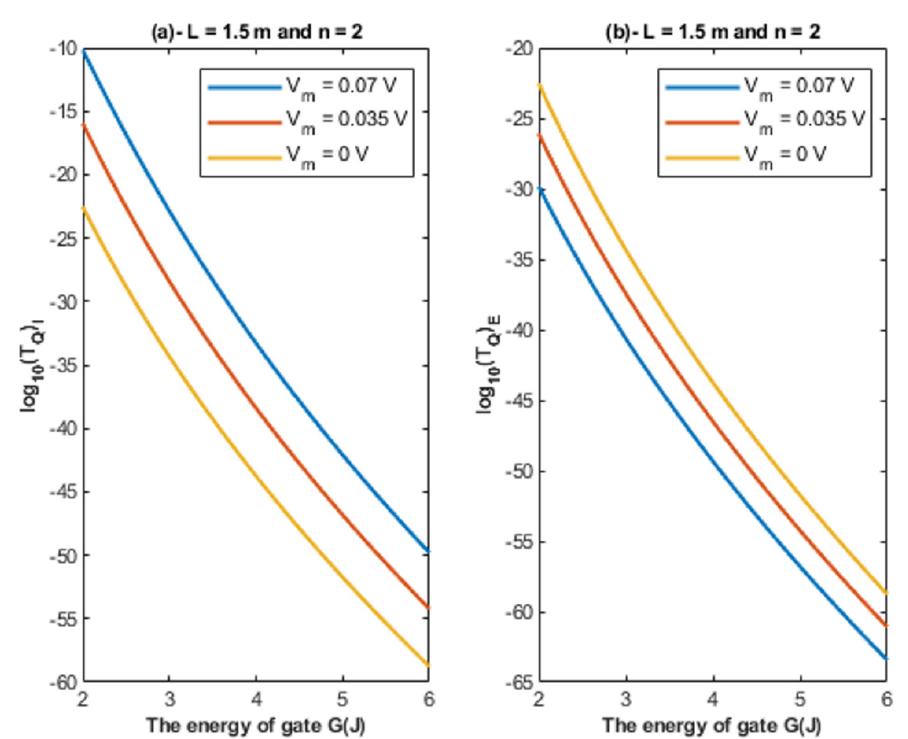
Figure 5. ( a , b ): The figure represents the relationship between the energy of gate G and the common logarithm of the tunneling probability of the intracellular chloride ions log tunneling probability of the extracellular chloride ion s are investigated at different values of membrane potential and according to the setting values indicated above each graph.